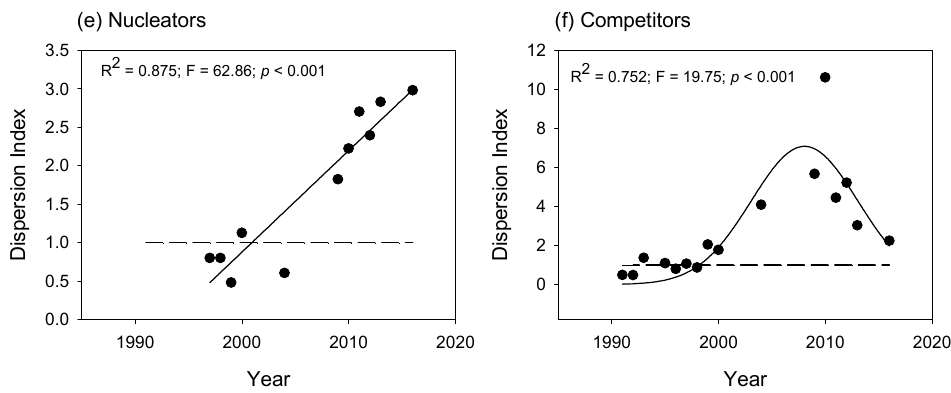
Figure 7. Dispersion index (D.I.) calculated for ( a ) all species, independently of their successional group; and then for each successional group, ( b ) facilitators; ( c ) colonizers; ( d ) sand binders; ( e ) nucleators and ( f ) competitors. When D.I. > 1, the distribution is aggregated; D.I. ≈ 1, the distribution is random, and when D.I. < 1, the distribution is regular [26]. Successional groups are described in Table 1. Dotted lines show D.I. = 1 for reference.